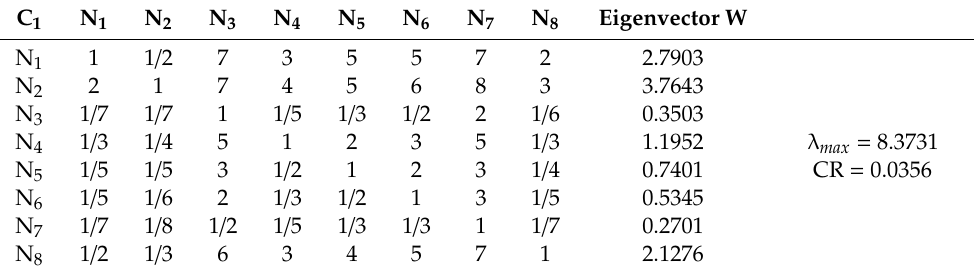
Table 8. N-C1 judgment matrix.